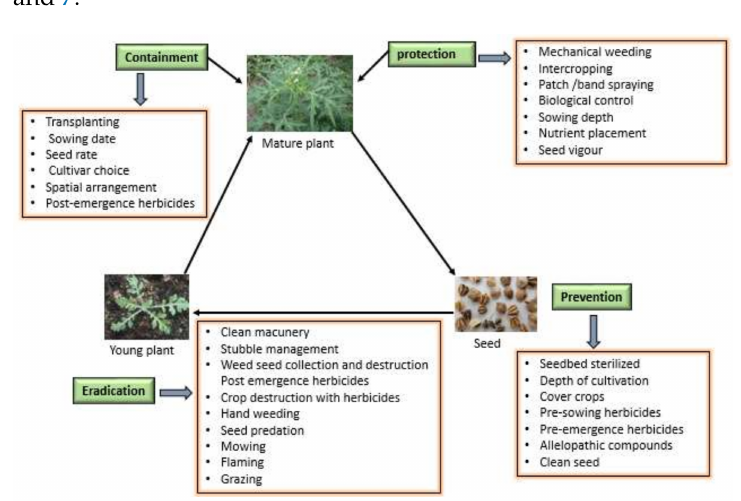
Figure 6. Management and control of Parthenium at different stages.